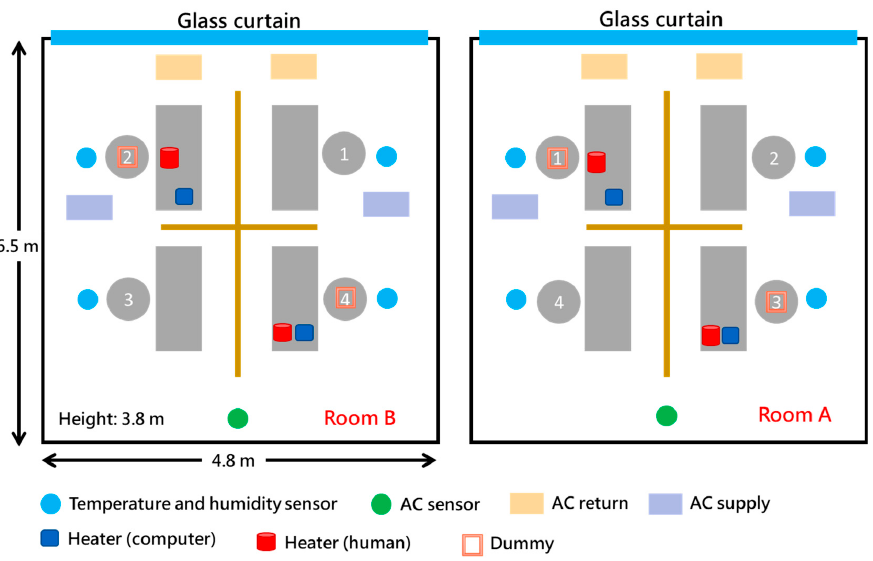
Figure 5. Experimental setup of the temperature and humidity sensors, air conditioning (AC) equipment, and heaters in test rooms A and B.